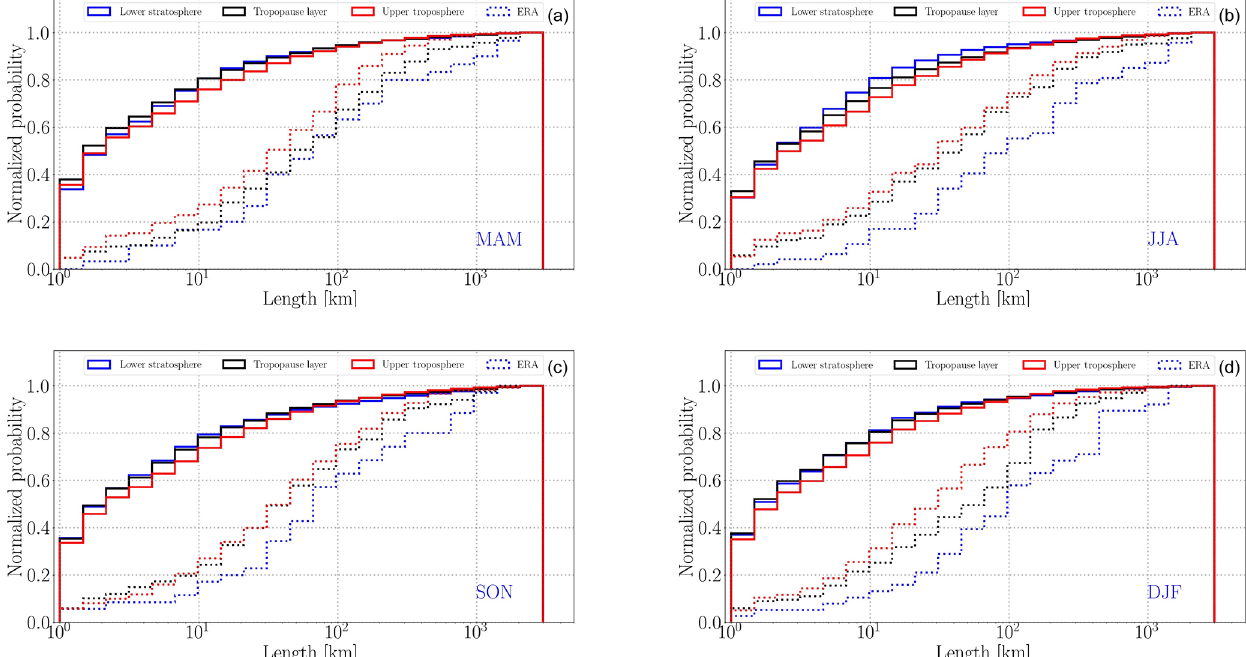
Figure 12. Seasonal cycle of the distance between ISSRs for lower stratosphere (blue), tropopause (black) and upper troposphere (red). Dashed lines show results for ERA. Panels (a) and (b) represent spring and summer months; (c) and (d) represent fall and winter months,